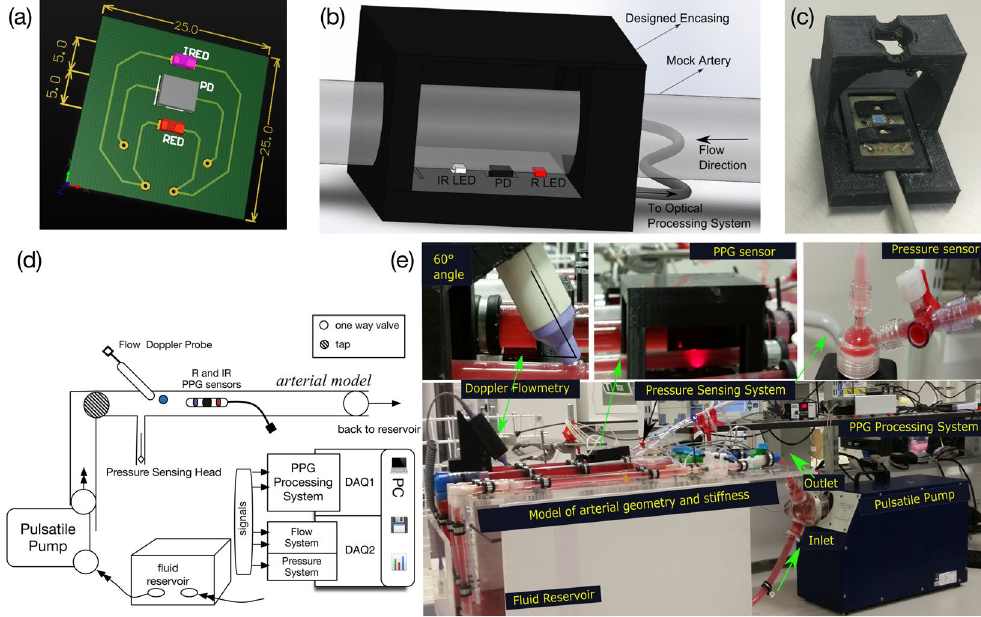
Figure 9. In vitro setup design and implementation. ( a ) Sensor PCB design, ( b ) 3D model of sensor and encasing, ( c ) close-up picture of inner encasing and sensor, ( d ) schematic of the experimental setup ( e ) picture of the final experimental